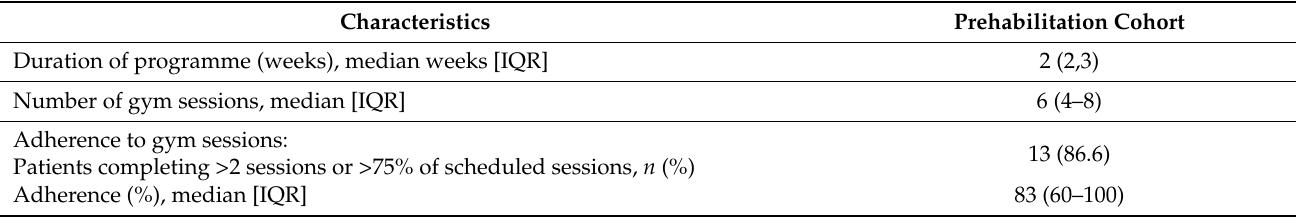
Table 2. Prehabilitation programme adherence and adverse